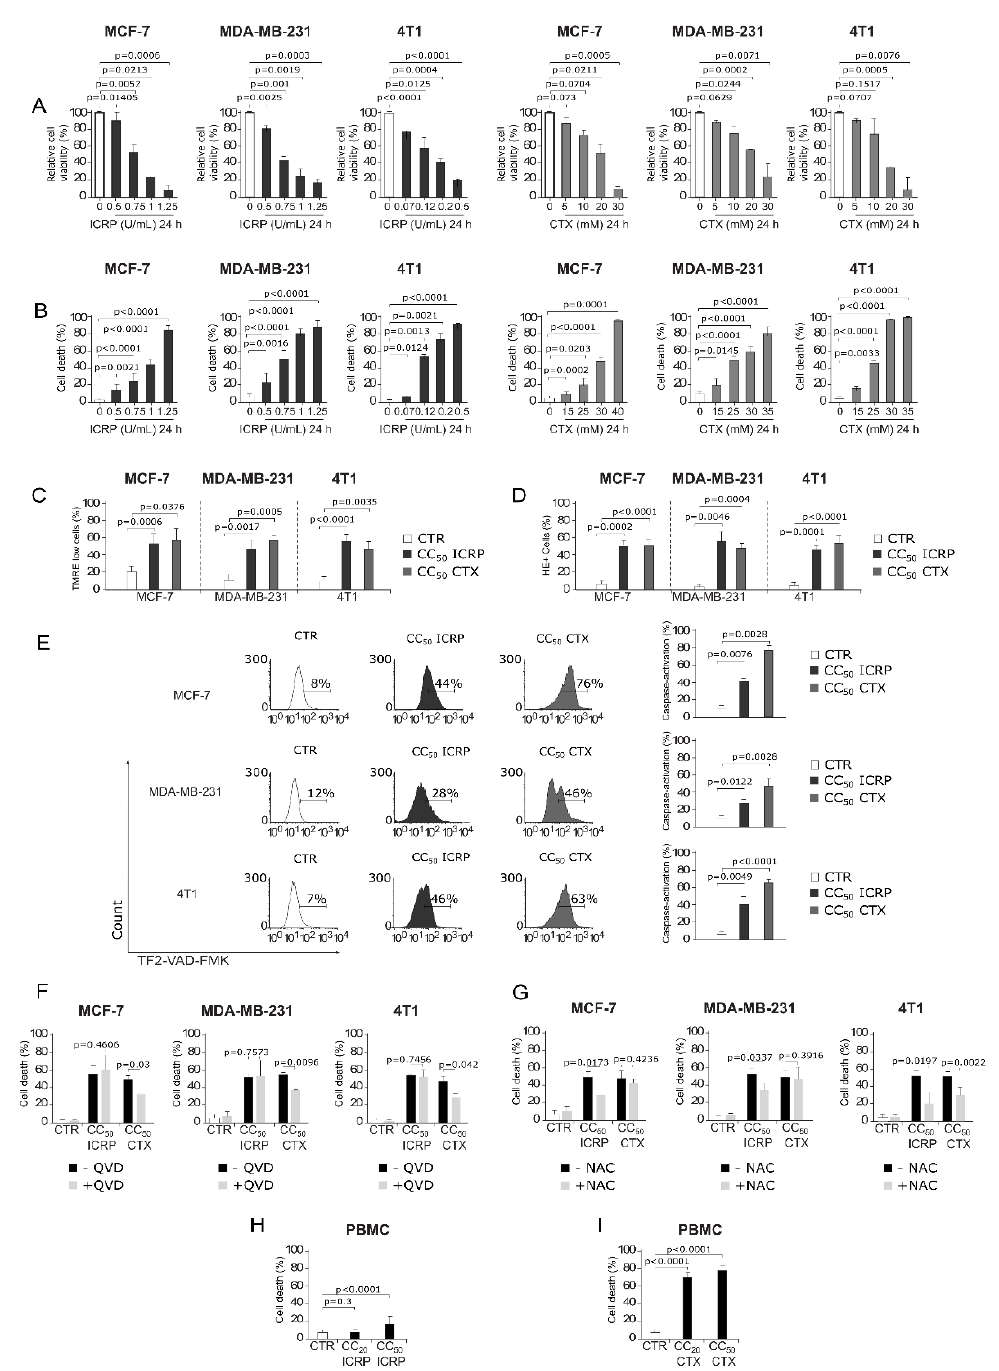
Figure 1: ICRP and CTX mechanisms of cell death in breast cancer cells and its effect in PBMC. MCF-7, MDA-MB-231 and 4T1 cells were treated for 24 h and biochemical features of cell death were evaluated and expressed as percentage. A ) Relative cell viability was determined using MTT assay considering control cell’s absorbance as 100 %. Flow cytometry was used to measure. B ) Cell death analyzed by AnnV/PI staining. For the next evaluations, 1, 0.75 and 0.12 U/mL of ICRP were used as CC 50 in MCF-7, MDA-MB-231 and 4T1 cells, respectively, as well as 30 mM for MCF-7, and 25 mM for MDA-MB-231 and 4T1 cells of CTX CC 50 -treatment. C ) Loss of mitochondrial membrane potential de- termined using TMRE staining. D ) ROS production analyzed by HE staining. E ) Caspase activation measured by TF2-VAD-FMK. ( F, G ) Cell death obtained by AnnV/PI of cells pre-treated in presence or absence of F) QVD or G) NAC. ( H, I ) Cell death obtained by AnnV/PI of PBMC treated with H ) ICRP or I ) CTX. Graphs represent means ±SD of triplicates from at least three independent